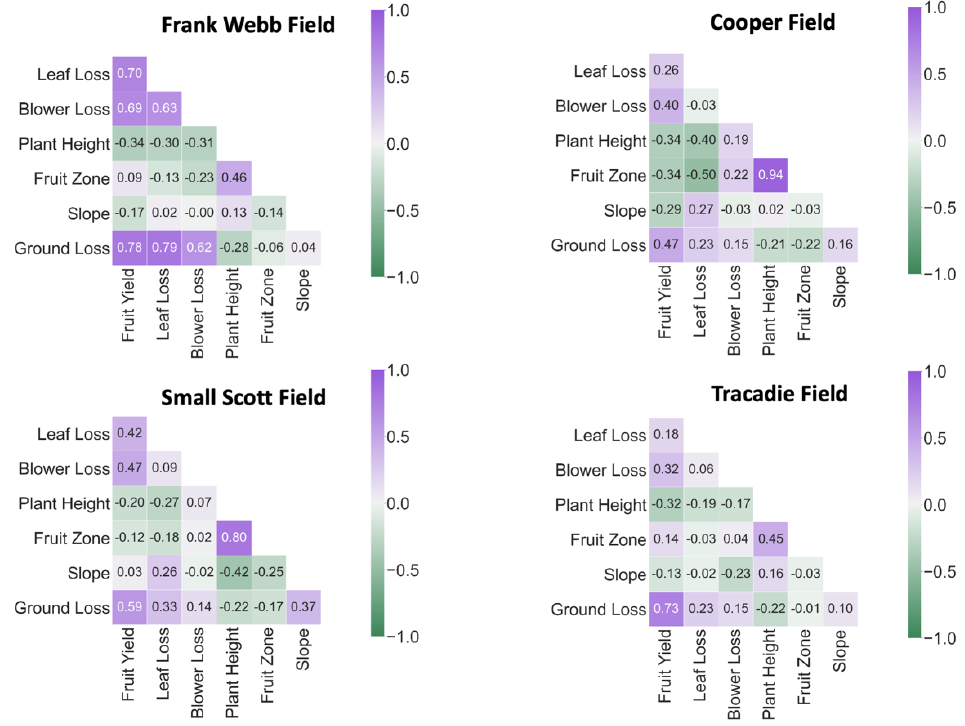
Figure 2. Pearson correlation analysis of selected variables for four fields in which all possible relationships within all variables are presented.